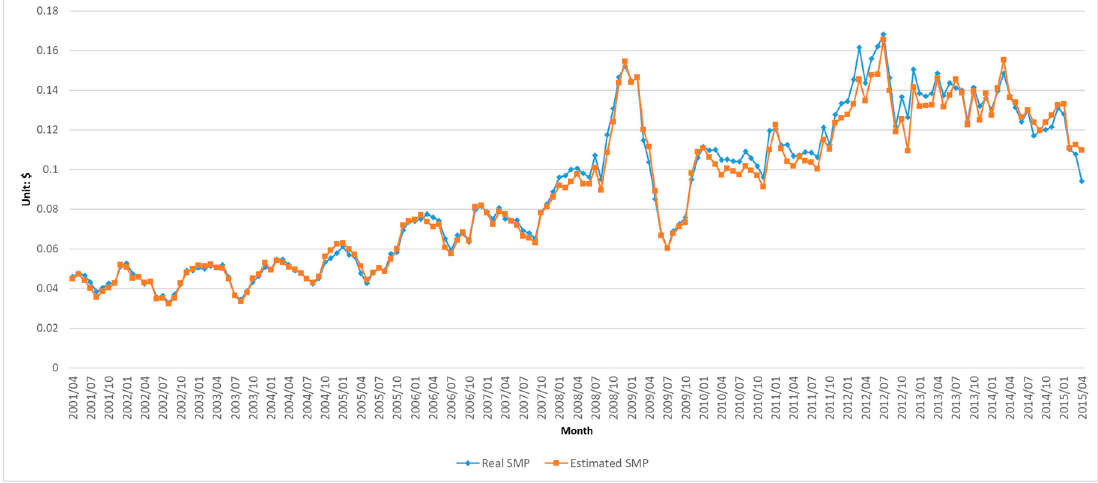
Figure 3. Comparison of real and estimated SMP, 2001–2015.